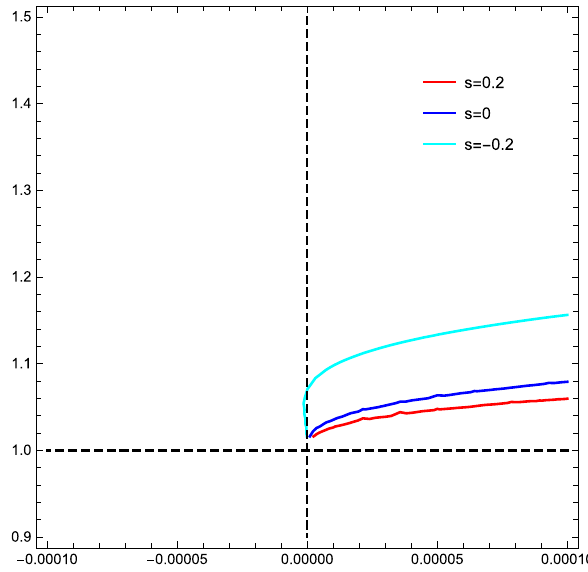
Fig. 6 The innermost stable circular orbit for co-rotating test body in term of L , around a black hole with a / M = 0 . 9999. In this case, r ISCO exists only for (cid:2) ≥ 0, except for negative spin